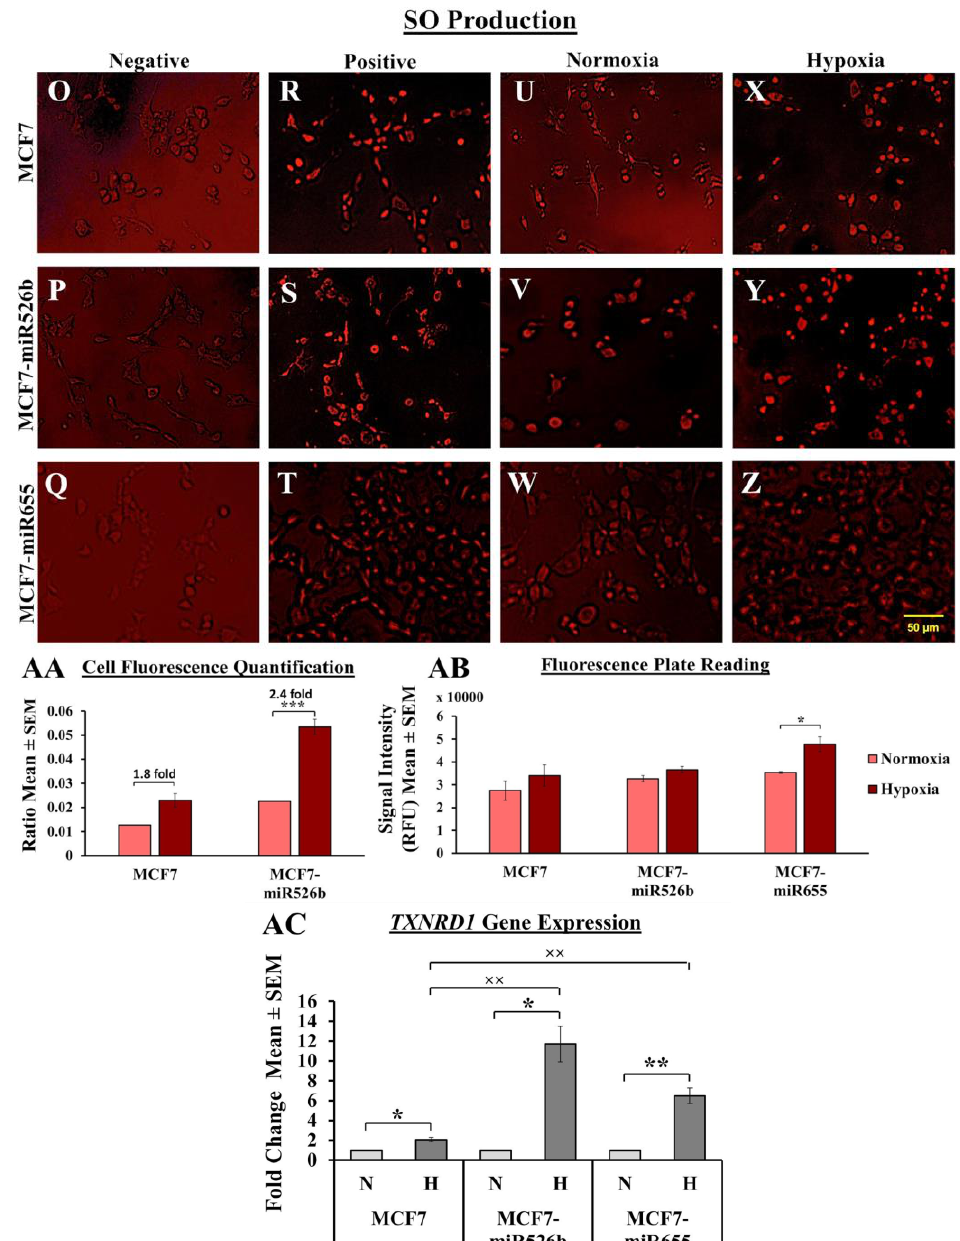
Figure 3. Fluorescence microscopy and fluorescence microplate assays to quantify ROS and SO production: MCF7, MCF7-miR526b, and MCF7-miR655 cells in ( A , B , C ) negative control, ( D , E , F ) positive control, ( G , H , I ) in normoxia, and ( J , K , L ) in hypoxia under the green filter for total ROS detection. ( M ) Quantification ratios of MCF7 and MCF7-miR526b cells positive for ROS in normoxia and hypoxia. ( N ) Fluorescence microplate assay to quantify total ROS production in MCF7, MCF7-miR526b, and MCF7-miR655 cells. Fluorescent SO-positive MCF7, MCF7-miR526b, and MCF7-miR655 cells ( O , P , Q ) in negative control, ( R , S , T ) in positive control, ( U , V , W ) in normoxia, and ( X , Y , Z ) in hypoxia under the red filter for total SO detection. ( AA ) Quantification ratios of MCF7 and MCF7-miR526b cells positive for SO in normoxic and hypoxic conditions. ( AB ) Fluorescence microplate assay to quantify total SO production in MCF7, MCF7-miR526b, and MCF7-miR655 cells. ( AC ) Gene expression of TXNRD1 measured with qRT-PCR. ‘N’ indicates normoxia, and ‘H’ indicates hypoxia. Scale bar represents 50 μM. ( M , N , AA , AB , AC ) Data are presented as the mean ± SEM of triplicate biological replicates; * p < 0.05, ** p < 0.01, *** p < 0.001, and xx indicates p < 0.01. * Also indicates comparison between normoxia and hypoxia of the same cell line and x, indicates comparison between cell lines only in a hypoxic condition.